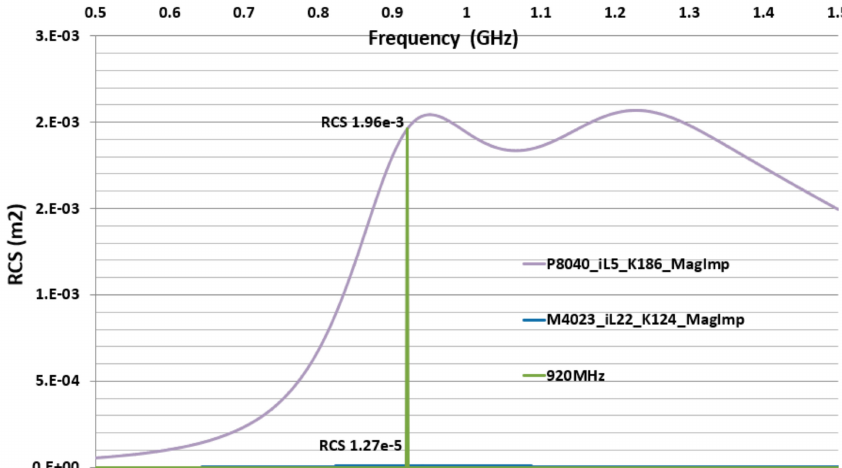
Figure 8. RCS comparison of CFTA M4023 and P8040.